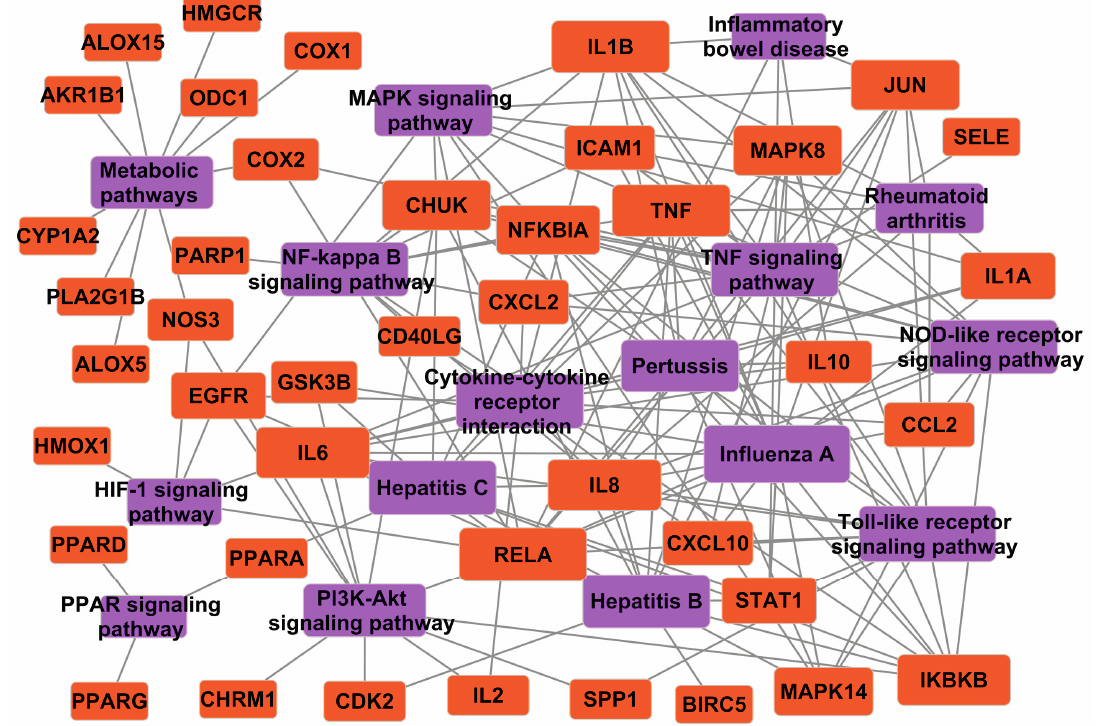
Figure 4. T-P network. The orange nodes represent the targets, while the purple ones the pathways. Node size is proportional to its